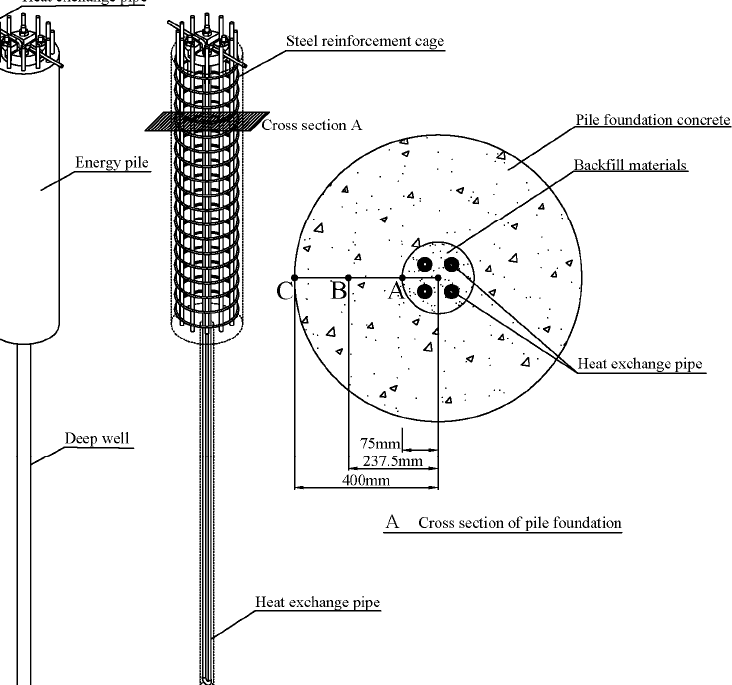
Figure 1. Schematic diagram of overall structure of deep buried pipe energy pile (Point A is located on the inner wall of pile foundation, point C is located on the outer wall of pile foundation, and point B is located in the middle of